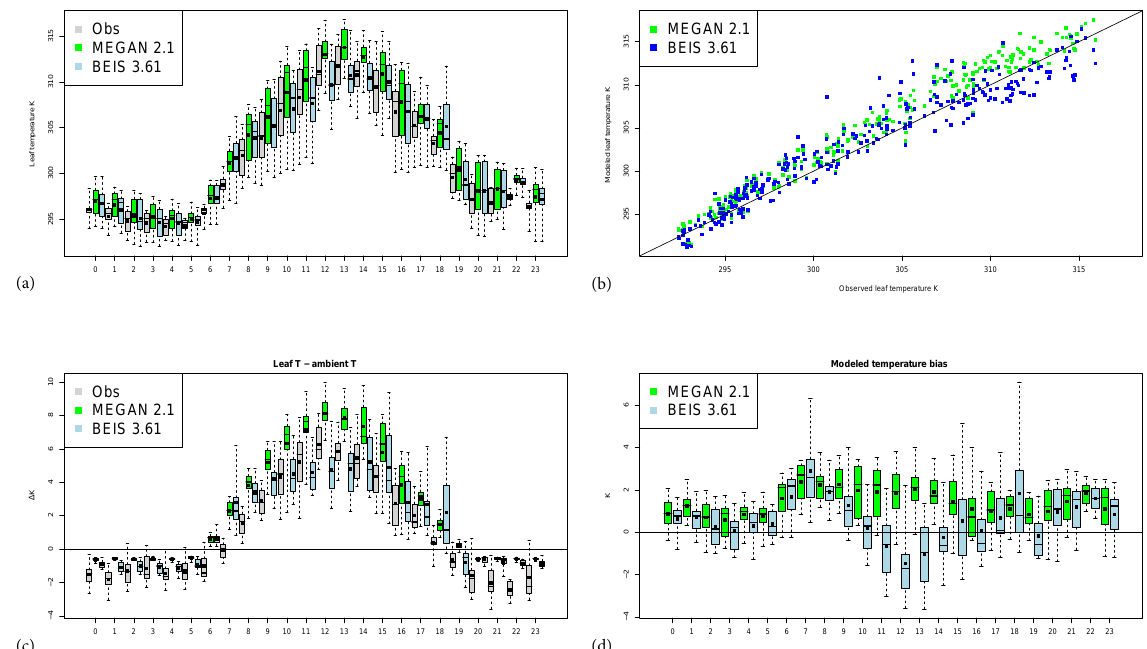
Figure 1. Diurnal observed, and MEGAN 2.1 and BEIS 3.61 estimated leaf temperatures (a) ; MEGAN 2.1 and BEIS 3.61 leaf temperature estimates plotted against skin temperature observations (b) ; observed, MEGAN 2.1, and BEIS 3.61 estimated gradient between leaf and ambient temperatures (c) ; MEGAN 2.1 and BEIS 3.61 estimated leaf temperature biases (model–observed) (d)